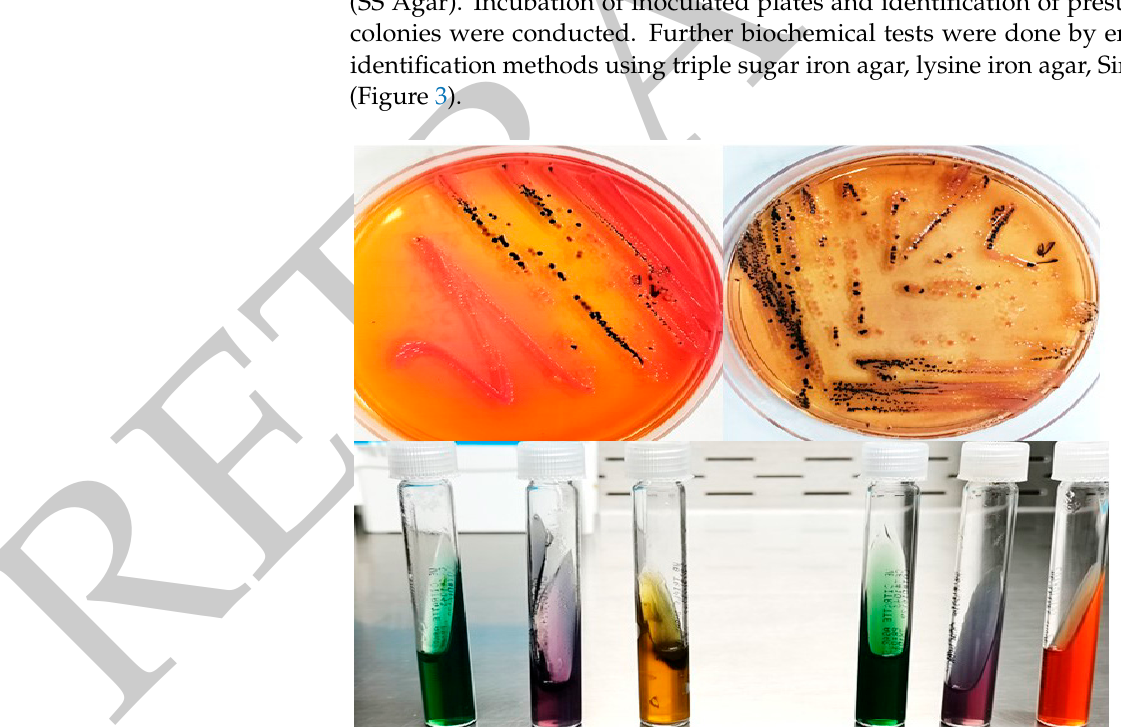
Figure 2. Selective media to detect different microorganisms in frozen and fresh burger samples and fast-food restaurants samples.